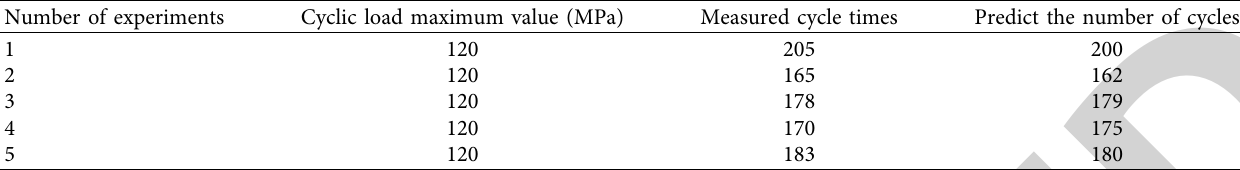
Table 4: Comparison of SWT method test results and predicted